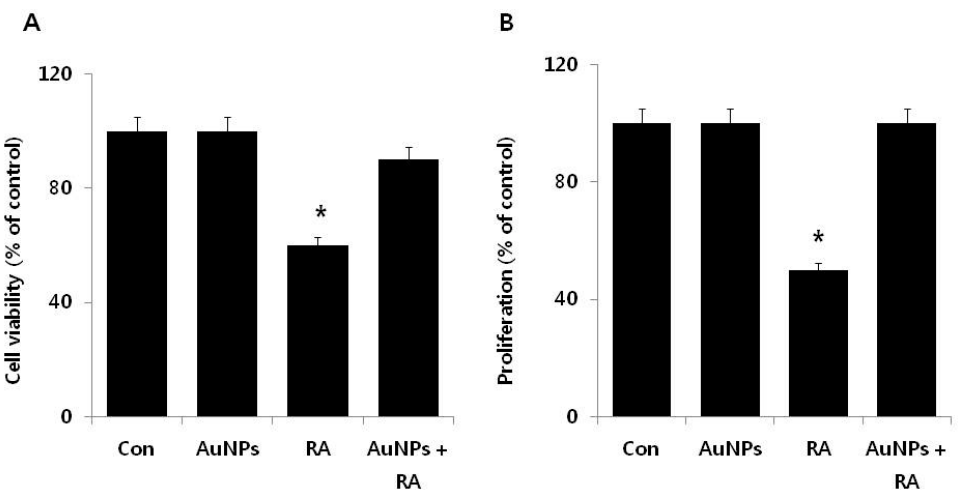
Figure 4. Effects of AuNPs on RA-induced cell death in F9 cells. The cell viability ( A ) and proliferation ( B ) of F9 cells were determined after a 24 h exposure to AuNPs (10 μ M), RA (10 μ M), and RA in the